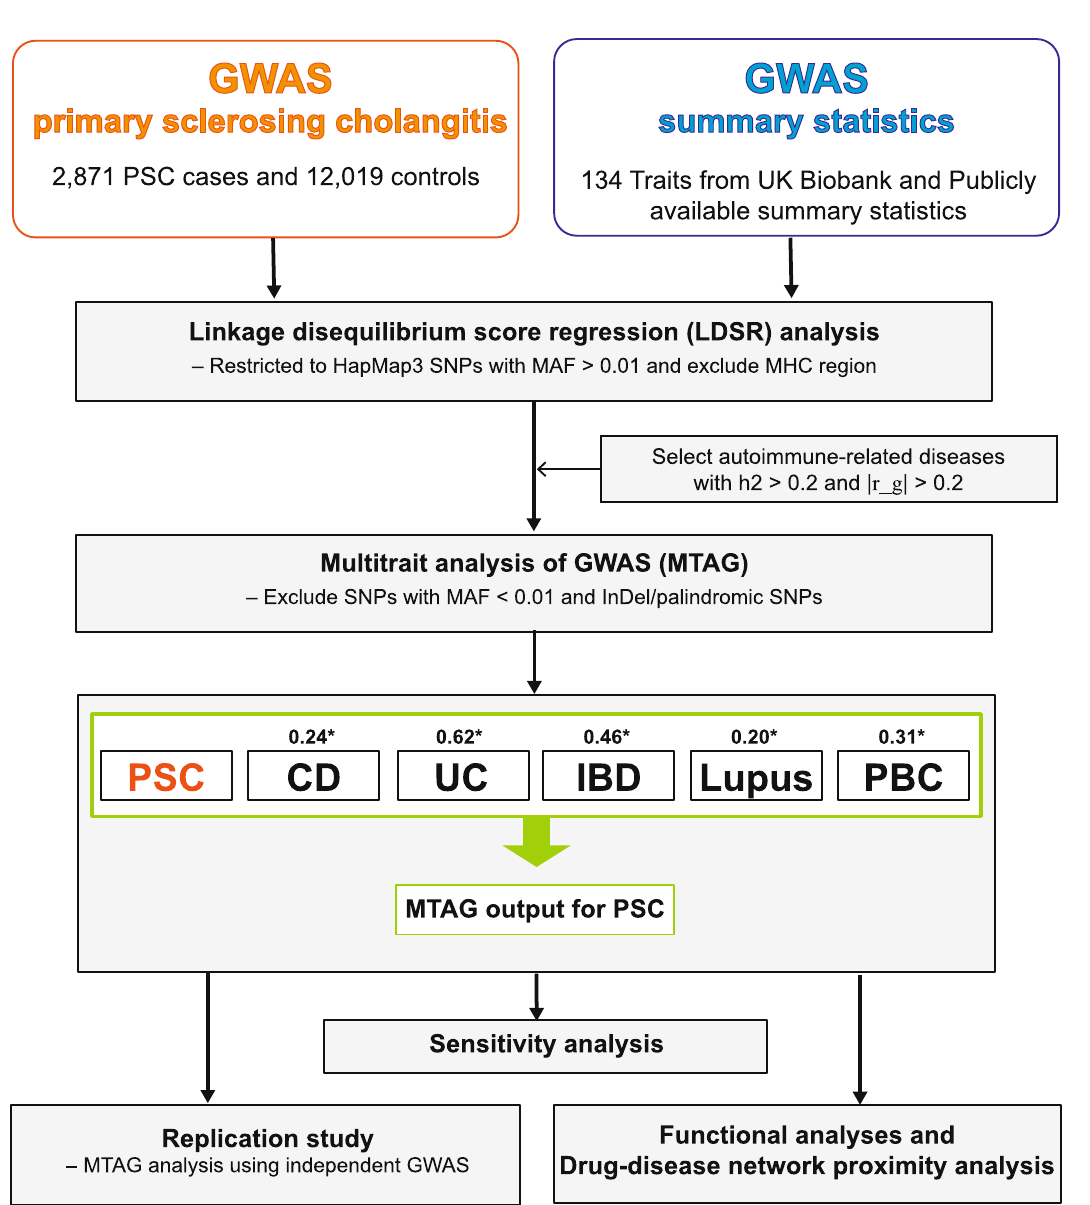
Fig. 1 | Flow chart of the analytical work fl ow in this study. h2 represents SNP- based heritability in the observed scale. |r_g| represents the absolute value of the pairwise genetic correlation between PSC and the traits studied. MAF stands for a minor allele frequency. MHC region stands for the major histocompatibility